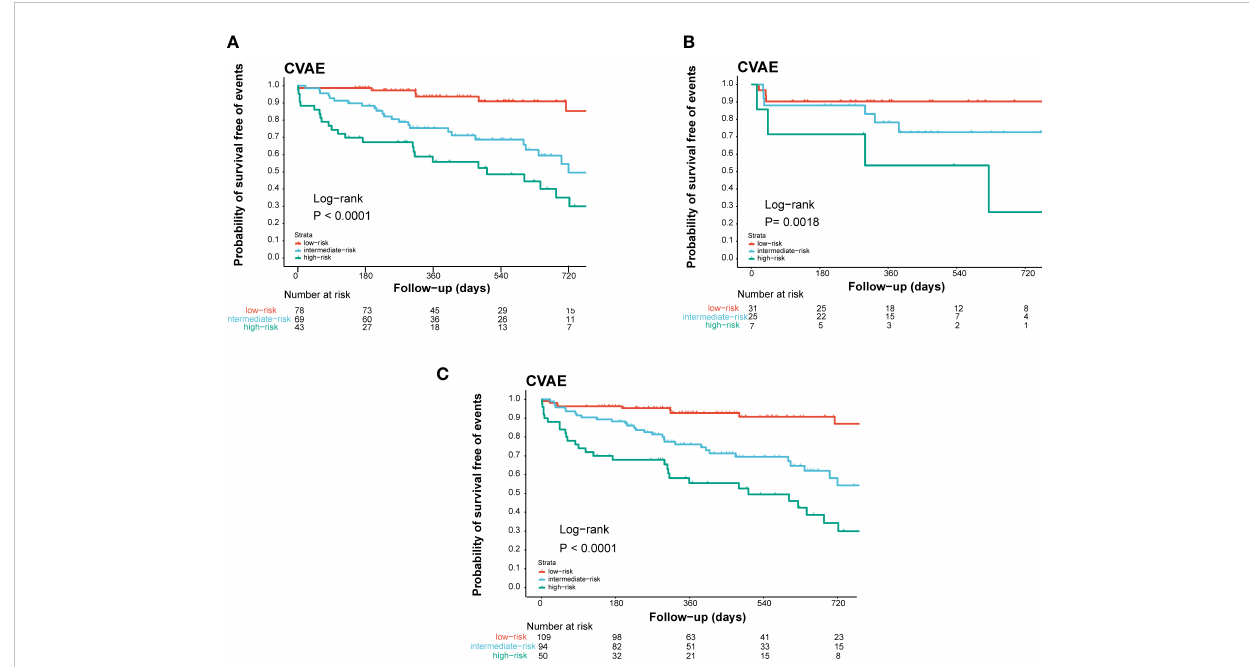
FIGURE 1 Validation of the prognostic index of CVAEs occurrence in NDMM patients. Kaplan – Meier estimates of CVAE-free survival in (A) the training cohort, (B) the internal validation cohort, and (C) the combined cohort validation cohort. High, high-risk group; Int, intermediate-risk group; Low, low- risk